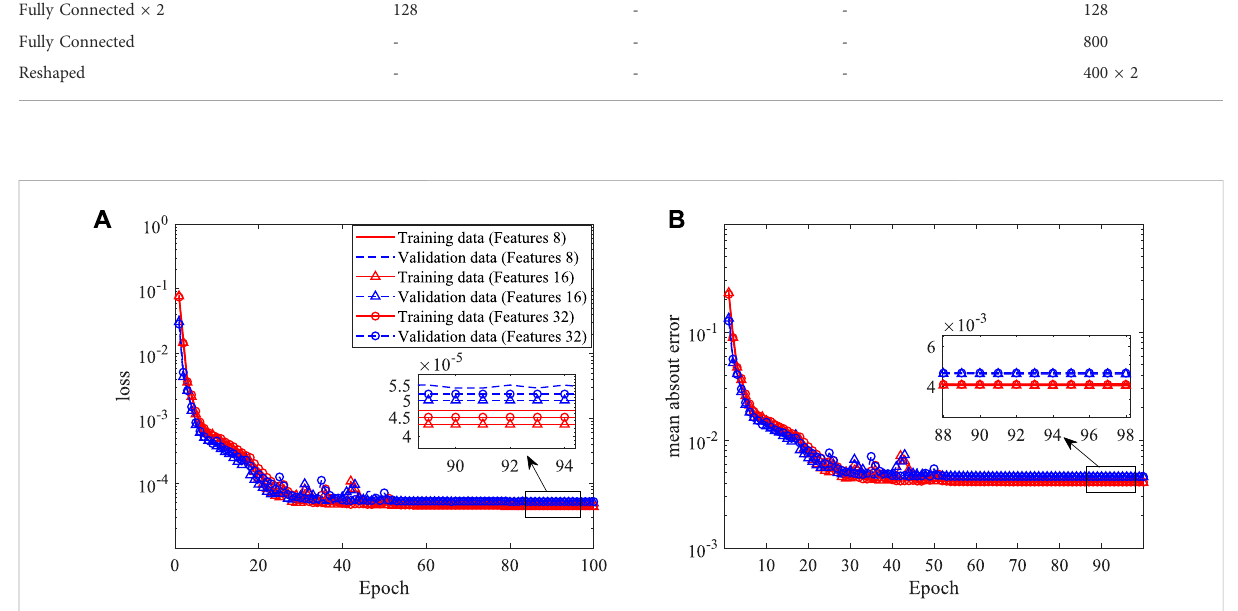
FIGURE 14 Histories of loss and mean absolute error in the shape construction of the 3D CNN: (A) loss, and (B) mean absolute error.